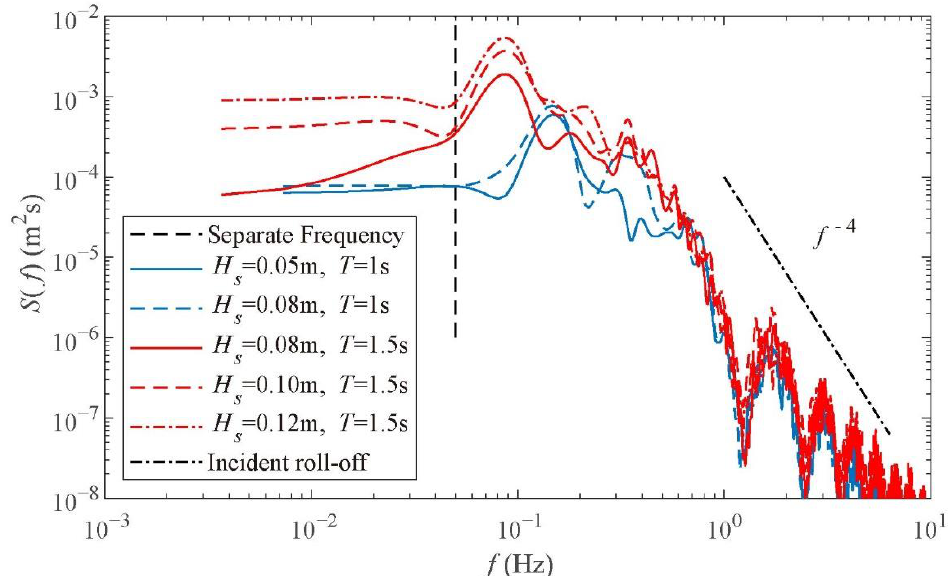
Figure 9. Swash spectrum evolution with the same experimental water depth and different water conditions (T01, T02, T03, T04, T05). Black dash line is the separation frequency of incident swash band and infragravity swash band.